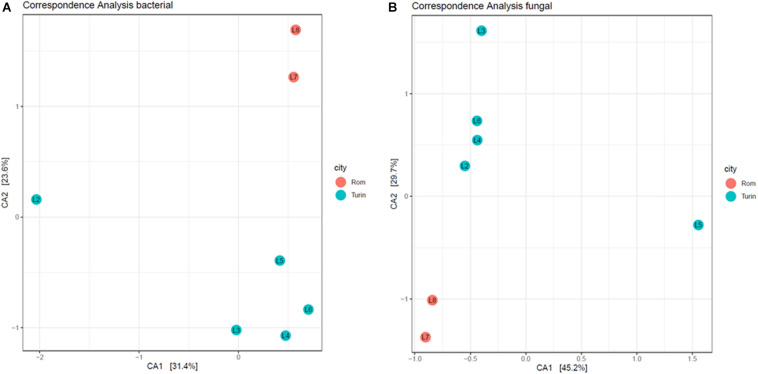
Canonical correspondence analysis plot of the first and second CA axis for bacterial (A) and fungal (B) abundance data. Dots represent samples (sample name is indicated within the dots) and colors represent the city where the drawings are located—Turin (blue) and Rom (red). Percentages indicate how much of the variability in the data is explained by the respective axis.